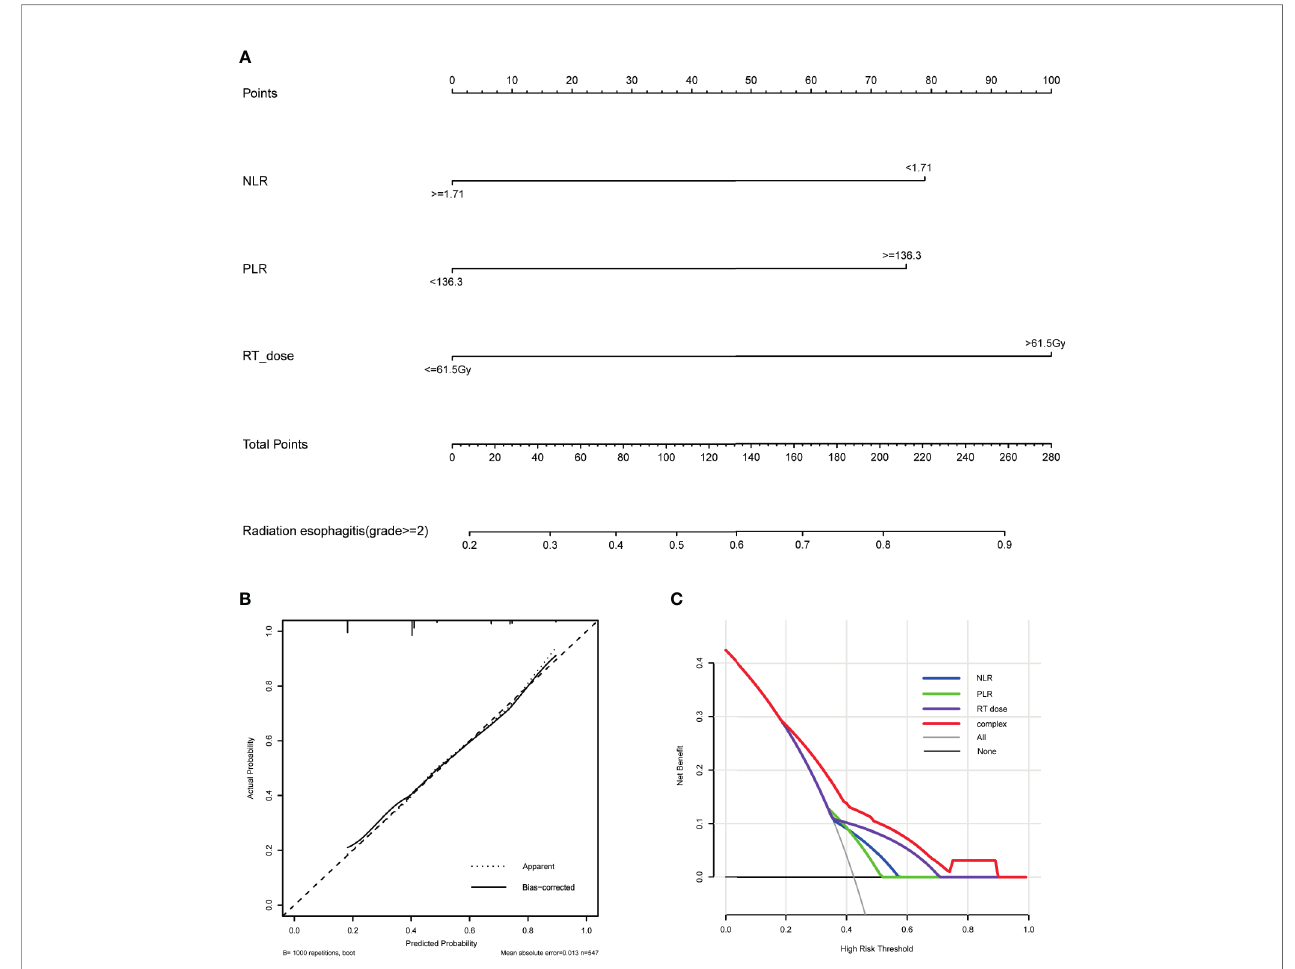
FIGURE 2 | Nomogram, calibration curve, and Decision curve for predicting the probability of grade ≥ 2 RE for the whole study population. (A) A nomogram that integrates RT dose, NLR, and PLR in ESCC patients. (B) The calibration curve of the nomogram predicting the occurrence of grade ≥ 2 RE. The x-axis and y-axis indicate the predicted and actual probabilities of having grade ≥ 2 RE, respectively. A 45° line represented optimal predictive values. (C) The decision curves of the nomogram predicting the occurrence of grade ≥ 2 RE. The x-axis shows the threshold probabilities. The y-axis measures the net bene fi t, which is calculated by subtracting the false positives and adding the true positives. The horizontal line along the x-axis assumes that no patient will have grade ≥ 2 RE whereas the solid gray line assumes that all patients will have grade ≥ 2 RE at a speci fi c threshold probability. The blue, green, purple and red line represents the net bene fi t of using the NLR, PLR, RT dose, and complex, respectively. RE, radiation esophagitis; RT, radiotherapy; NLR, neutrophils-lymphocyte ratio; PLR, platelets-lymphocytes